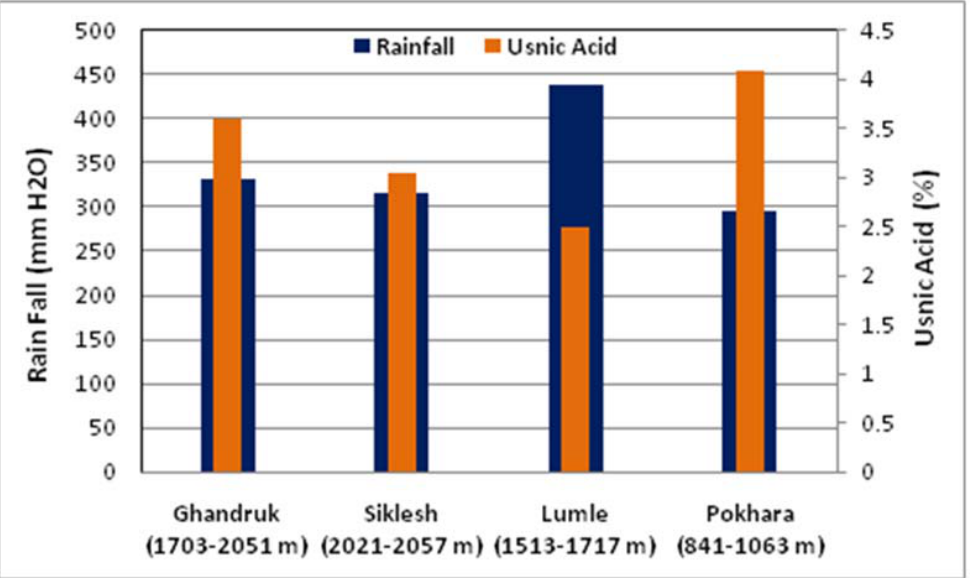
Figure 5. Mean usnic acid of P. flexilis and rainfall (between the years 2006–2015) at four major collection sites. Altitude ranges are noted in the parentheses. (Rainfall Source: Department of Metrology, Pokhara, Nepal, Hydrology and Metrology, Pokhara, Nepal, 2016).